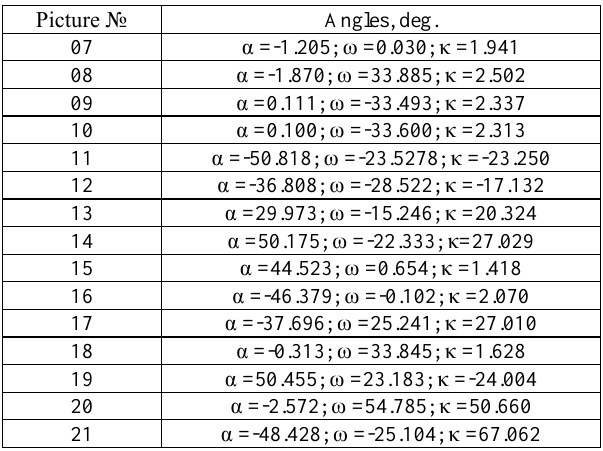
Table 2. Values of image orientation angles (Eulerian angles) obtained as a result of photogrammetric processing of the images